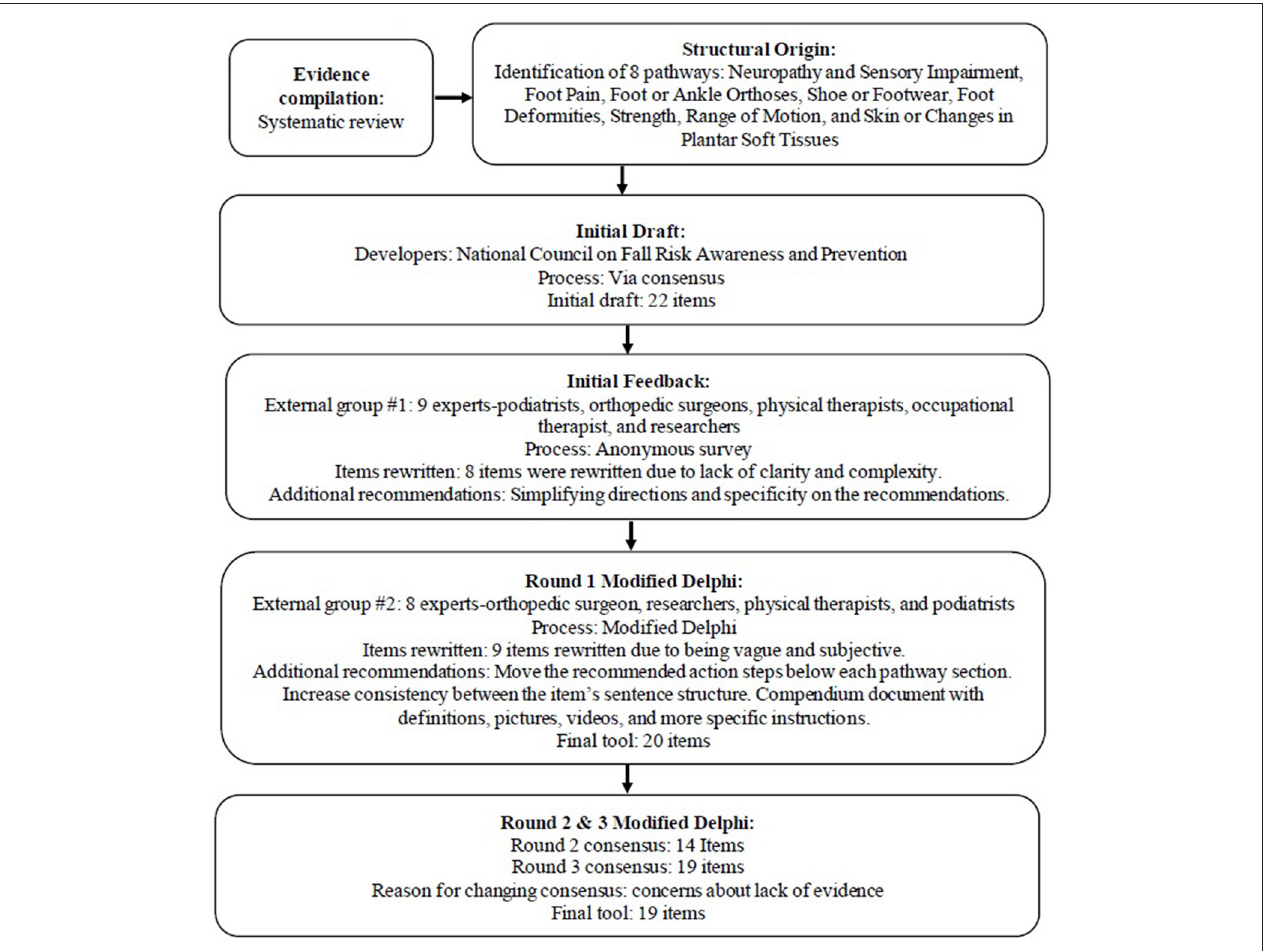
FIGURE 1 | Flow diagram outlining Feet/Footwear-Related Fall Risk Screening Tool development